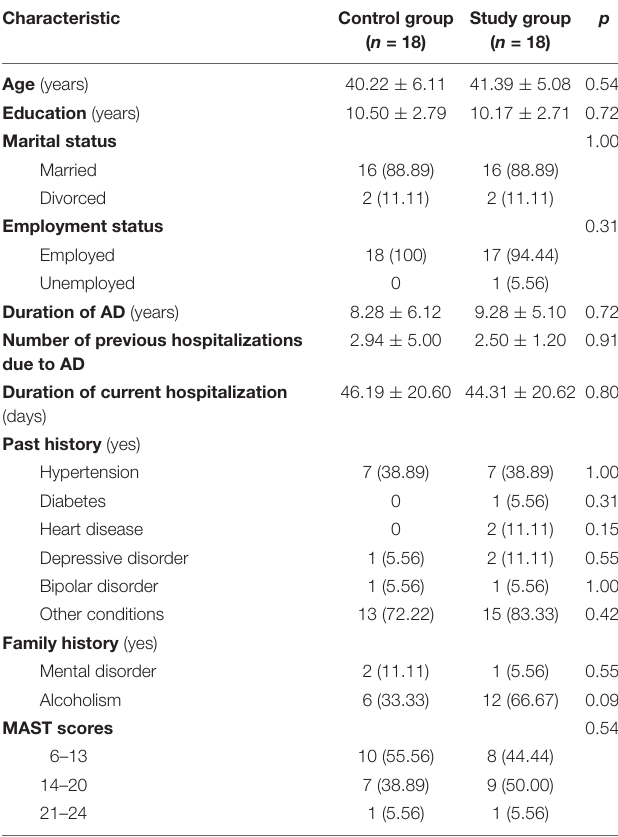
TABLE 1 | Baseline differences in demographic variables and clinical